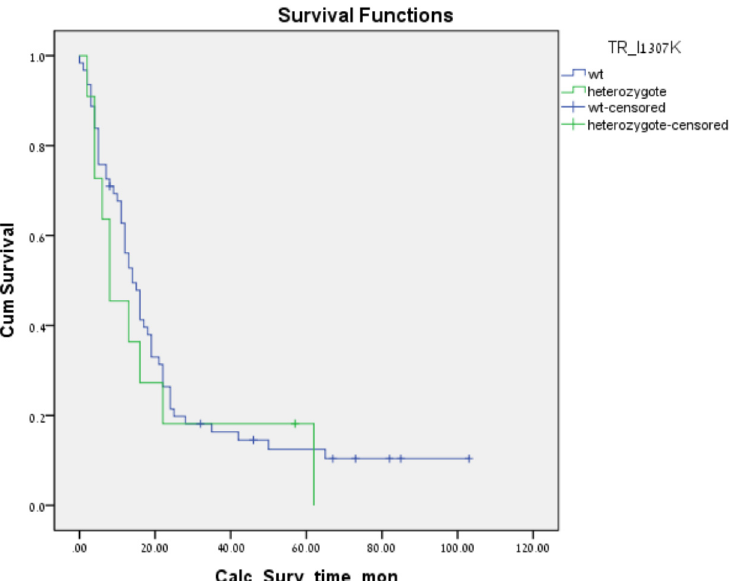
Fig 1. Kaplan-Meir survival curve for APC I1307K